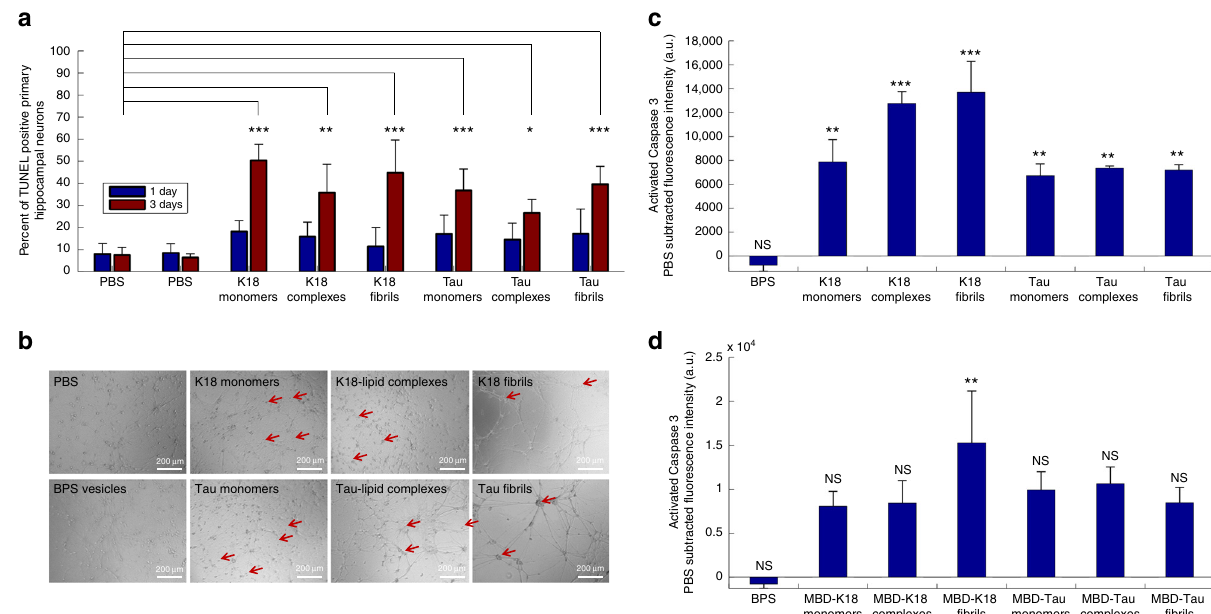
Fig. 8 Tau and K18 protein/phospholipid complexes, fi brils and monomers are toxic to hippocampal neurons and exert their toxicity through different mechanisms. Hippocampal mouse primary neurons were treated with PBS, BPS vesicles (controls), 3 µ M Tau or K18 monomers, protein/phospholipid complexes or sonicated fi brils and fi xed at 1 or 3 days post treatment. a Apoptotic cells were stained using the TUNEL assay, the neuronal population was stained using NeuN, and the nucleus was stained using DAPI. The percentage of apoptotic neurons [(TUNEL + and NeuN + cells)/NeuN + cells] was quanti fi ed as described in the methods. No statistical signi fi cance was observed at 1 day, whereas all species were signi fi cantly toxic at 3 days. Bars are mean ± S.D. b Tau and K18 monomers, fi brils, and protein/phospholipid complexes exert different effects on primary hippocampal neuron morphology. At 3 days, the PBS-treated and BPS-treated neurons present a healthy neuronal morphology with round cell bodies and extended neurites (left panels). Neurons treated with monomeric Tau and K18 show many condensed neurons (second left panels, arrows). Neurons treated with K18 or Tau fi brils clumped together, linked by bundles of neurites (second right panels, arrows). Tau/phospholipid complexes presented both condensed and clumped cell bodies, with bundled neurites (right bottom panel, arrows). K18/phospholipid complexes induced condensation of cell bodies and shrinkage of the neurites (right top panel, arrows). c Apoptotic cell death was con fi rmed using the CaspaTag fl uorescein caspase 3 activity kit (Axxora) as described in the methods section. All species exhibited signi fi cant toxicity at 3 days post treatment. Bars are mean ± S.E.M. d The level of apoptosis induced by MBD-Tau and MBD- K18 species was assessed using the caspase 3 activity kit as described in the methods. The level of toxicity was higher than that of the BPS-treated neurons, but toxicity was only signi fi cant in the case of the MBD-K18 fi brils. Bars are mean ± S.E.M. (* p < 0.05, ** p < 0.01, *** p <